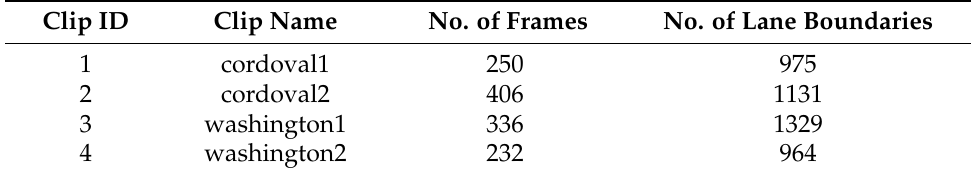
Table 2. Caltech dataset used in the evaluation.